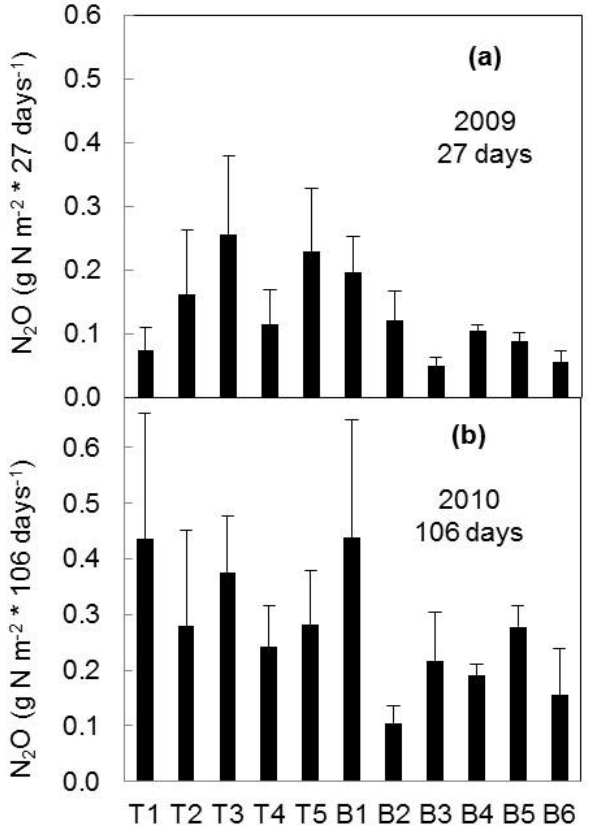
Fig. 6. ( (a) Cumulative N 2 O fluxes (gN 2 O-Nm − 2 ) during sum- mer 2009, from 12 July to 8 August, 27 days) and ( (b) 2010, from 10 May to 24 August, 106 days) at individual plots ( n = 3). Error bars represent standard error.